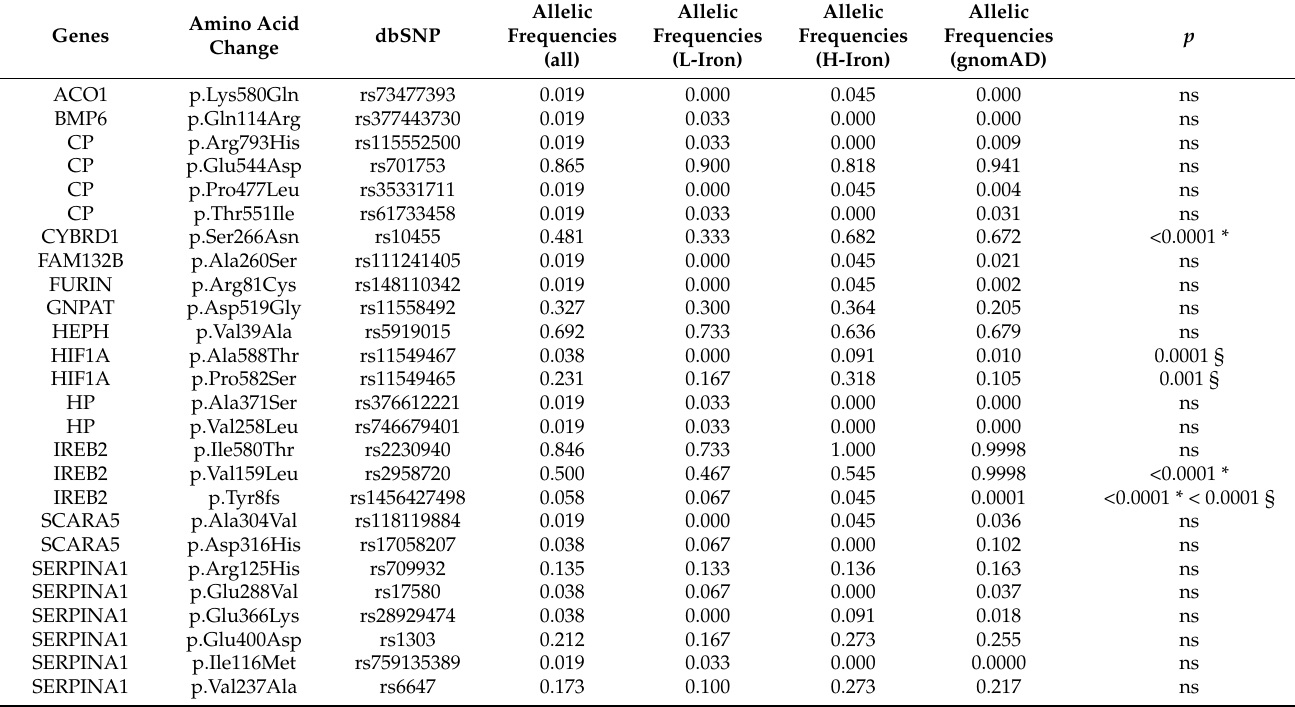
Table 3. List of the 41 exonic non-synonymous variants and their allelic frequencies in all 26 patients, subgroups (L-Iron and H-Iron) and Genome Aggregation Database